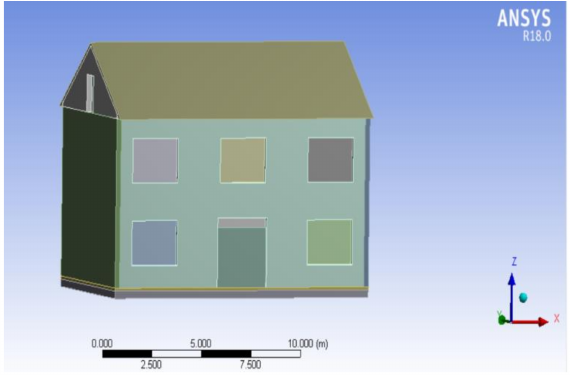
Figure 5. Floor plan of the representative building.